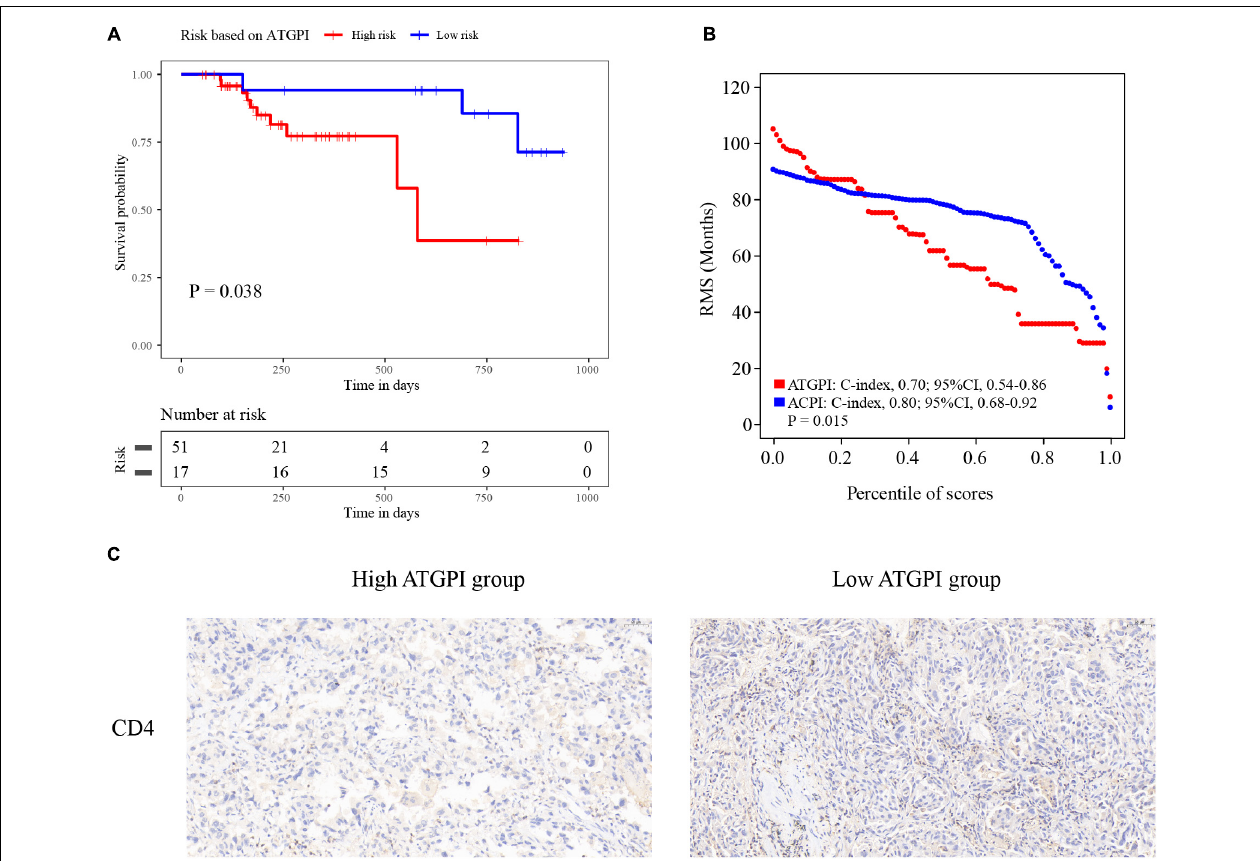
FIGURE 7 | The Kaplan–Meier curves for the autophagy-related gene pair index (ATGPI) and restricted mean survival (RMS) curves for the ATGPI and autophagy clinical prognostic index (ACPI) in the Union hospital (UH) cohort. (A) The Kaplan–Meier curves showed that patients were stratified into different prognostic groups by the ATGPI. (B) The RMS curves revealed that a superior estimation for overall survival was achieved by the ACPI in the UH cohort. (C) Immunohistochemistry (IHC) analysis showed the proportions of tumor-infiltrating CD4 + T cells were higher in the low-ATGPI group.